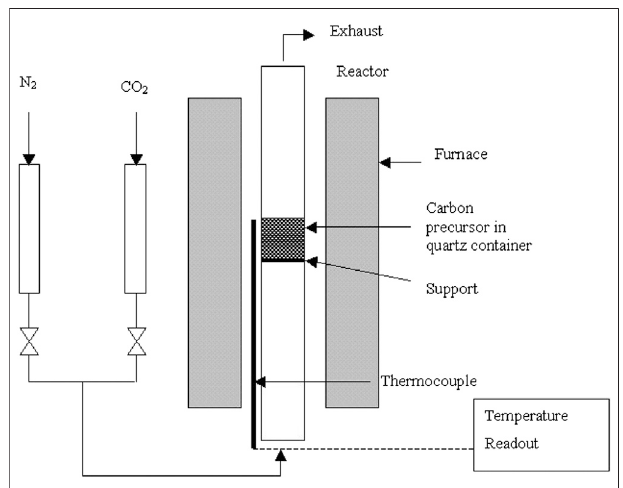
FIGURE 1 | Schematic layout of vertical furnace used for char and activated carbon